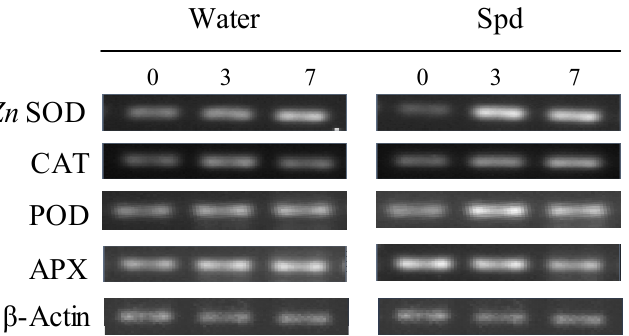
Figure 6. The effect of seed soaking with water or spermidine (Spd) on ( A ) superoxide dismutase (SOD) gene; ( B ) catalase (CAT) gene; ( C ) guaiacol peroxidase (POD) gene and ( D ) ascorbate peroxidase (APX) gene relative expression ratio in the process of seeds germination (7 days) under water stress induced by 15% PEG. Vertical bars indicate ± SE of mean ( n = 4). Different letters above columns indicate significant difference. LSD ( p ≤